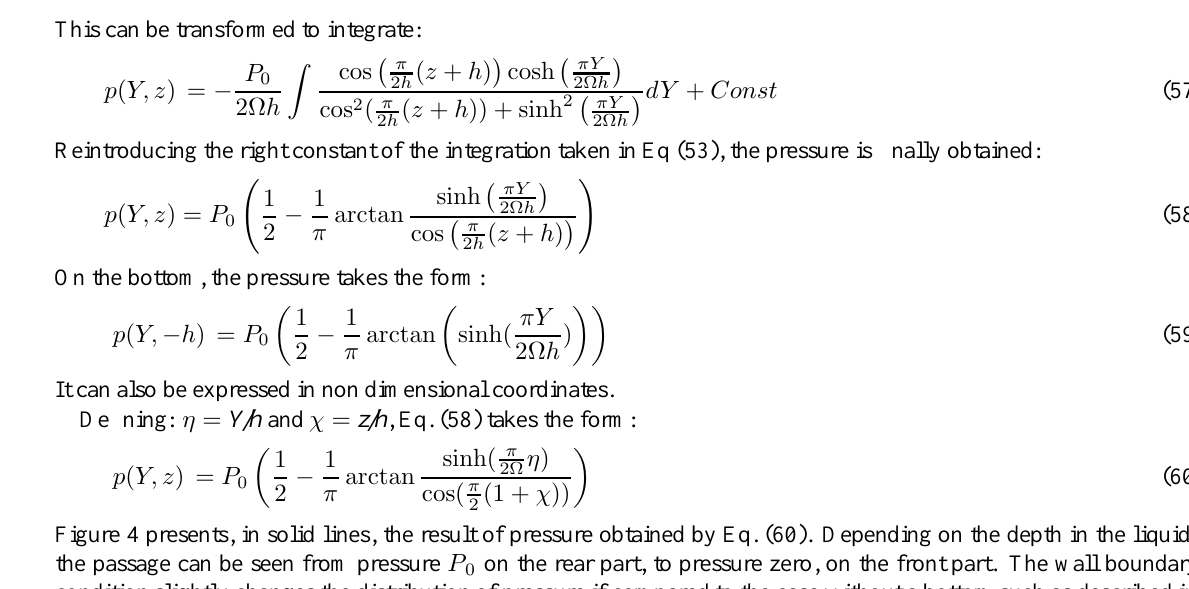
Fig. 4. Acoustic pressure in a strip of liquid loaded by a subsonic stationary pressure step, plotted at a 3 meter width interval around the load front. Solid lines: exact stationary pressure. Dotted-lines: transient pressure (numerical) after a travel distance of 100 meters of the load